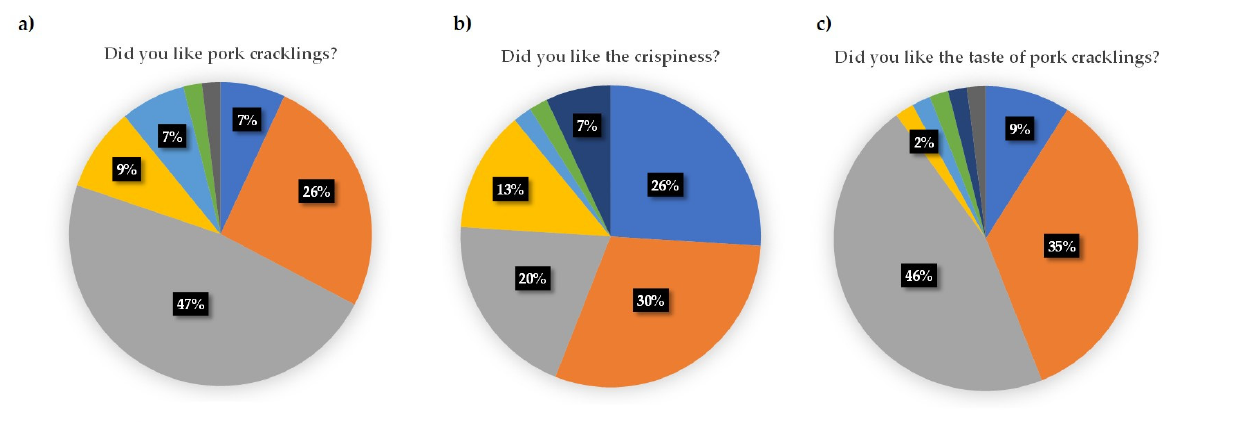
Figure 3. Results of the consumer preference test ( n = 55). ( a ) Consumers’ opinions about the prod- uct. ( b ) Consumers’ opinion about the crispiness of the product. ( c ) Consumers’ opinion about the taste of the product.